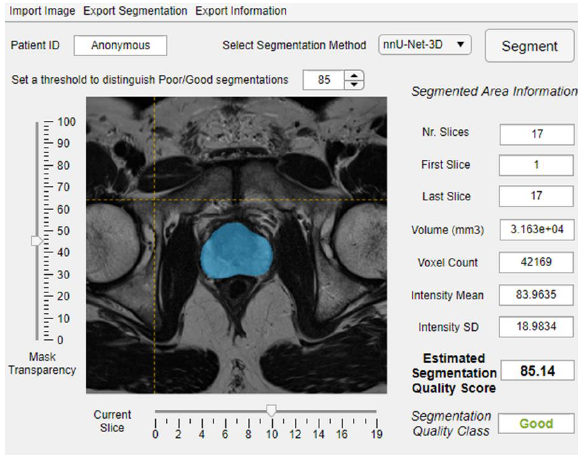
Figure 2. An example of integrating the proposed quality control system within image analysis software.